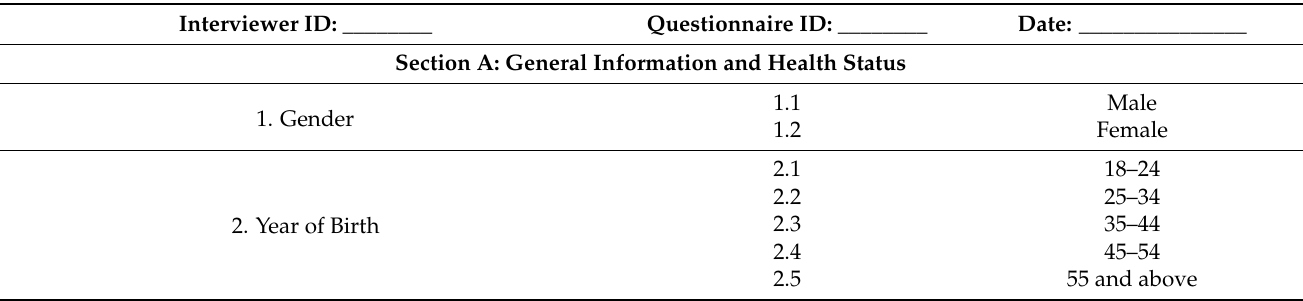
Table A1. COVID-19 vaccination acceptance